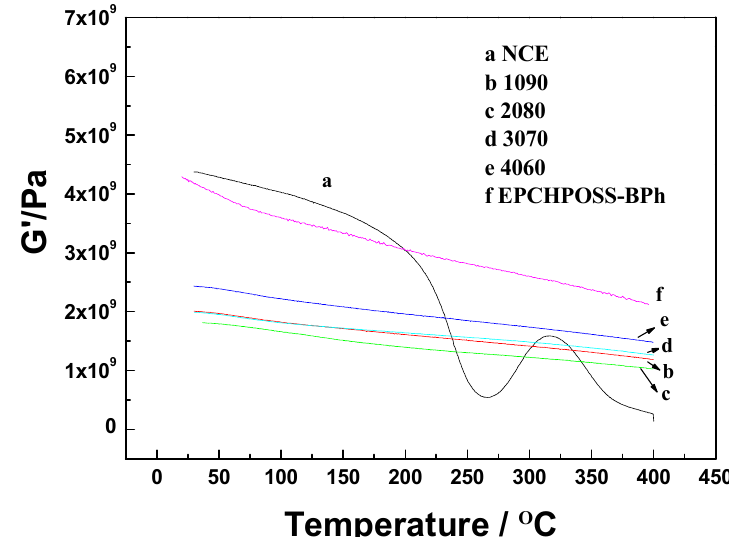
Figure 9. Dynamic storage modulus (G ′ ) as a function of temperature for NCE, EPCHPOSS–BPh, 1090, 2080, 3070, and 4060 polymers under a nitrogenous atmosphere.